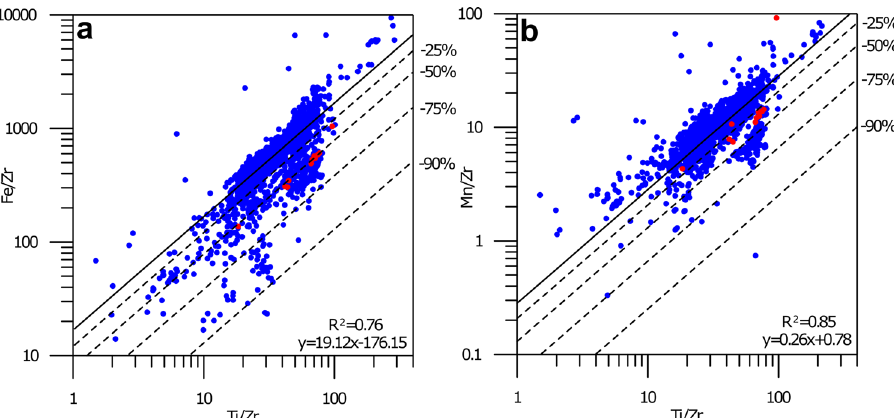
Fig. 4 Plots of Fe/Zr and Mn/Zr vs. Ti/Zr for the Aleutian arc. Presented here are data for ( a ) Fe and ( b ) Mn. In blue are GeoRoc-derived protolith compositions, from which the linear relationships indicated the lower right of each panels are de fi ned. Red circles indicate measured altered ash deposit analyses, plotted against the expected trend for unaltered material. The dashed lines indicate the percentage depletion. Similar graphs for all other active volcanic regions can be found in Supplementary Figs. 4 –